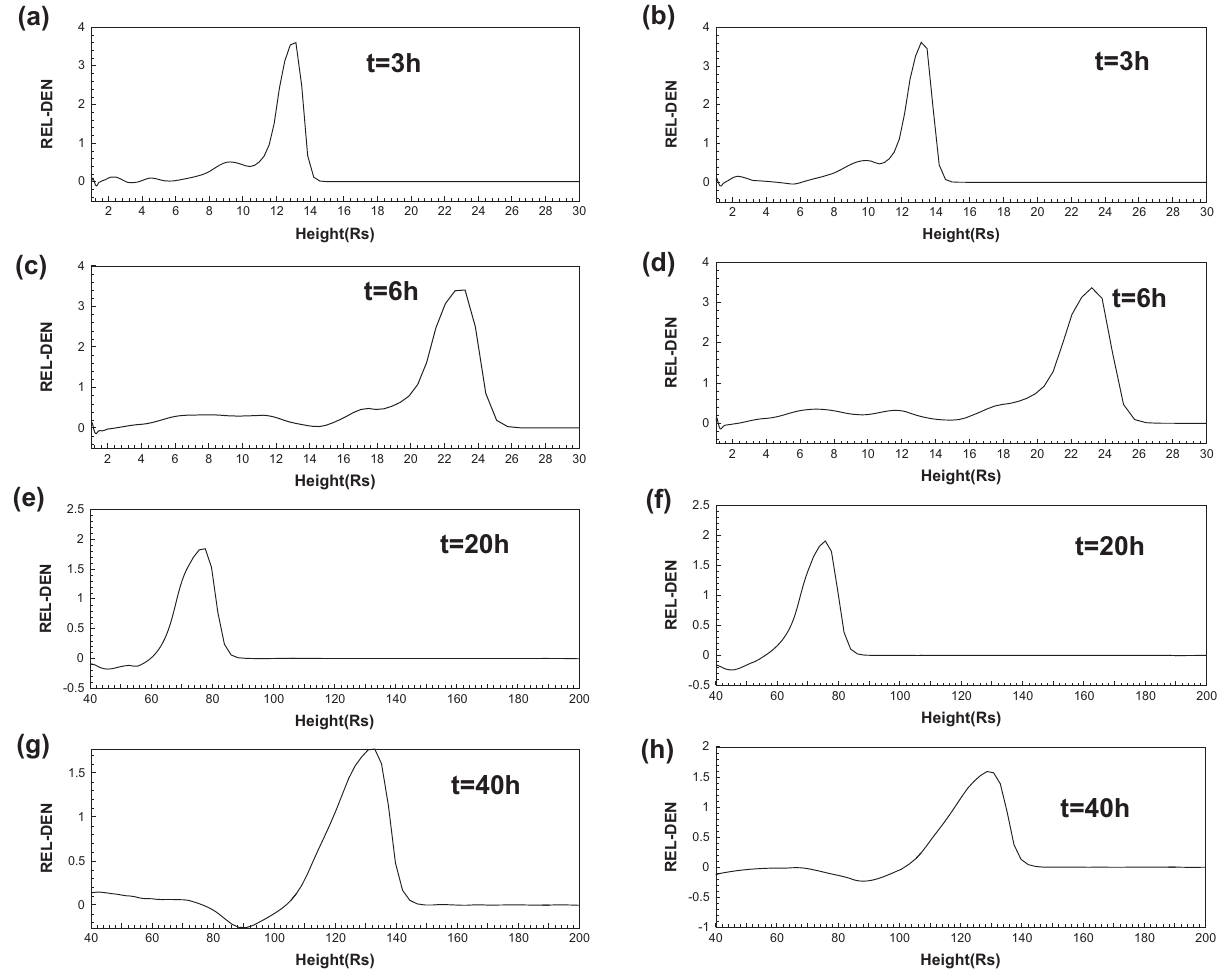
Fig. 8. Evolution of the relative density q (cid:4) q 0 versus heliocentric distance along h = 90 (cid:3) , / = 190 (cid:3) (left column) and h = 90 (cid:3) , / = 180 (cid:3) (right q 0 column) at t = 3, 6, 20, and 40 h, respectively. The top two rows (a, b, c, d) show the domain from 1 R s to 30 R s , while the bottom two rows (e, f, g, h) view from 40 R s to 200 R s